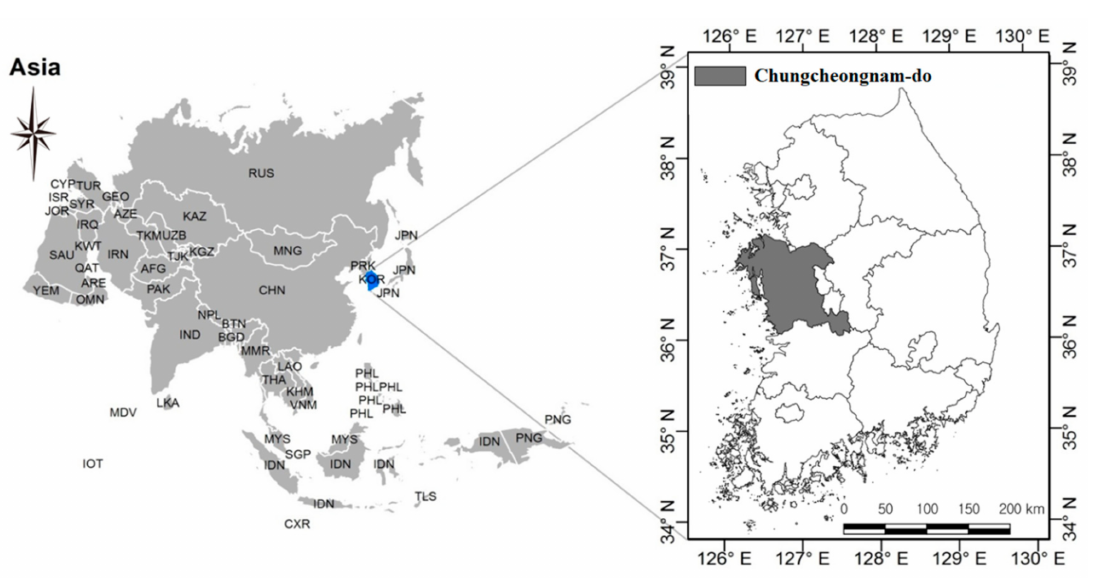
Figure 1. Map of the study